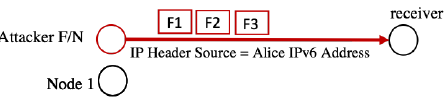
Figure 7. Spoofing attack.